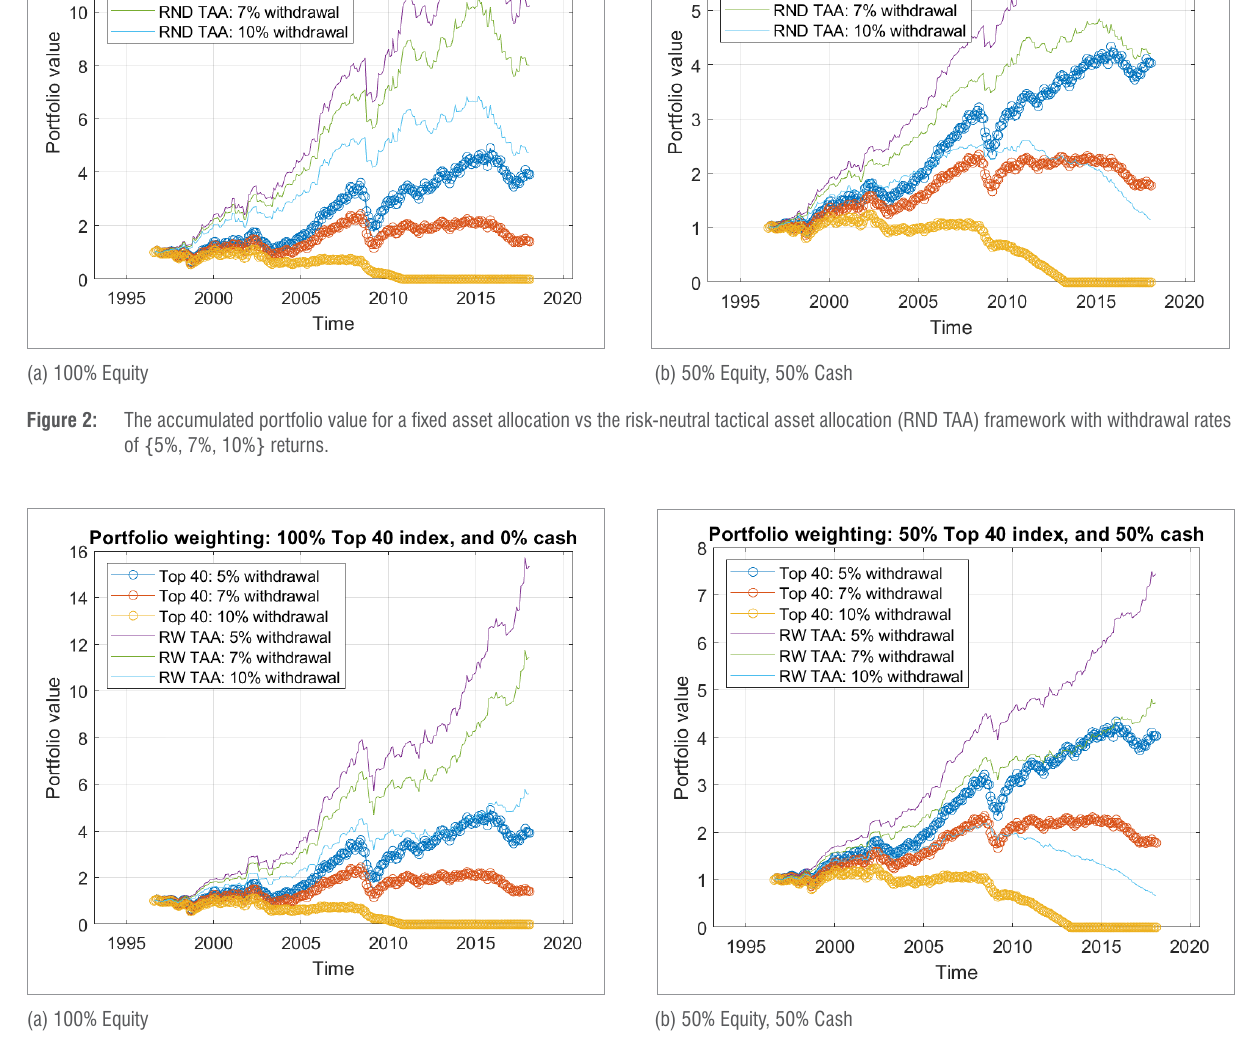
The accumulated portfolio value for a fixed asset allocation vs the real-world tactical asset allocation (RW TAA) framework with withdrawal rates of {5%, 7%, 10%}